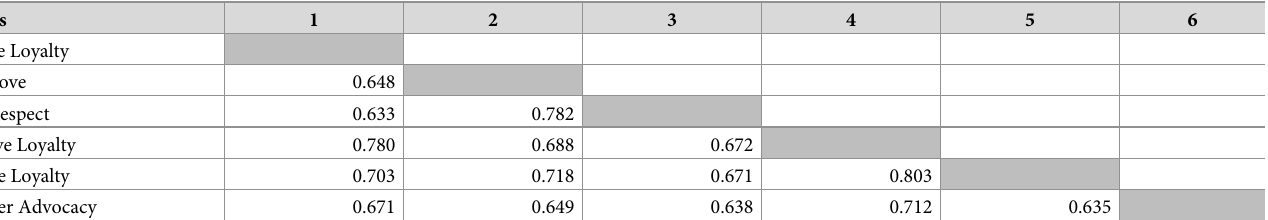
Table 2. Discriminant validity